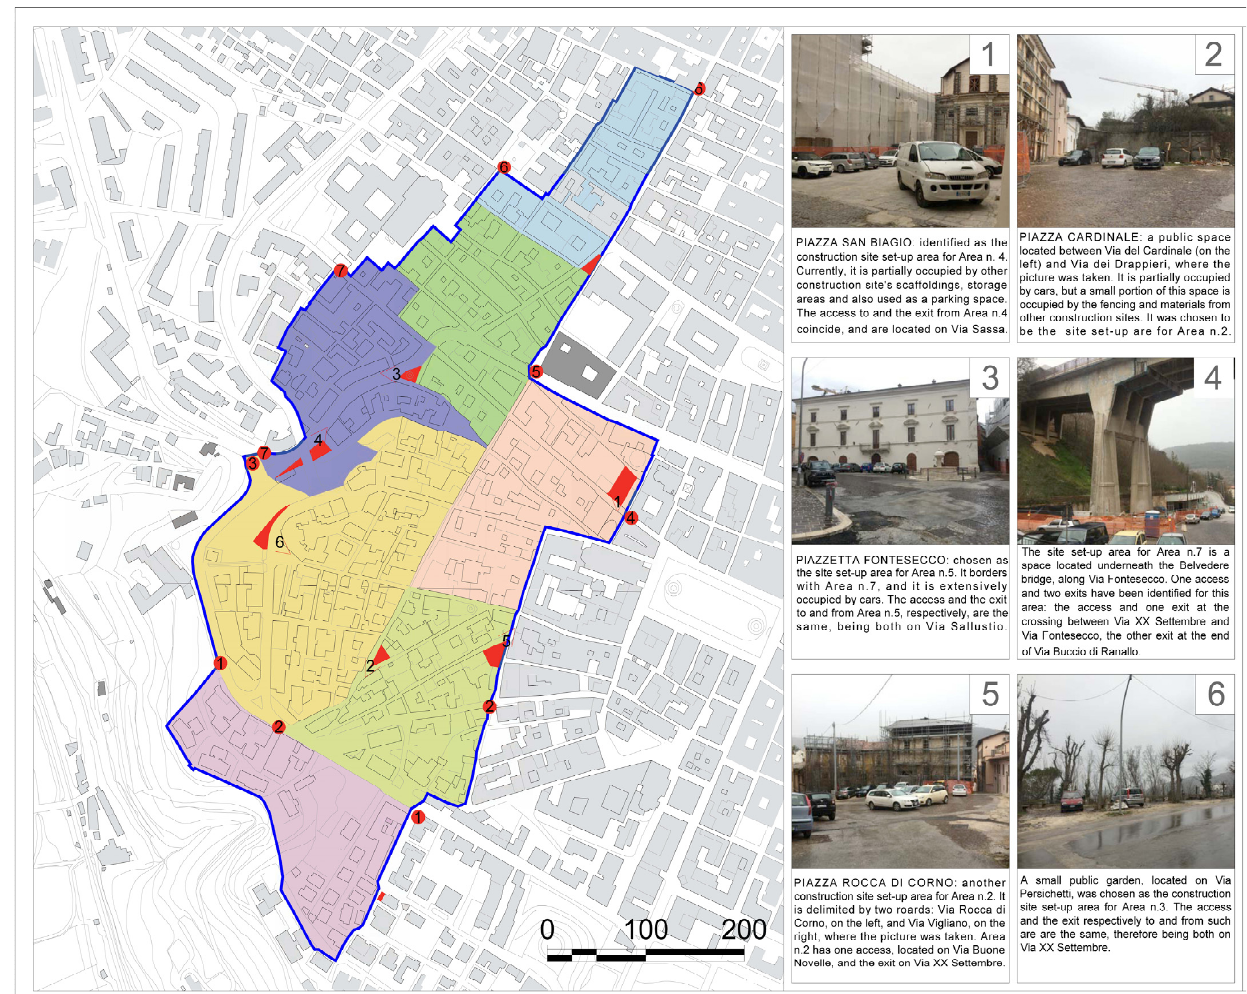
Figure 3. Organization of construction sites within the historic center of L’Aquila, aimed at the optimization of the phases for the utility reconfiguration. In the subfigures there is an analysis of the main public spaces that can be used to allocate each set ‐ up area for the instalment of the auxiliary factors.